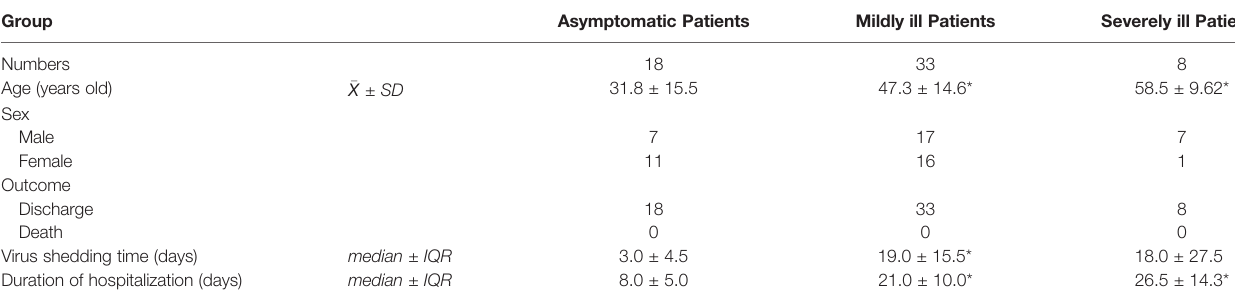
TABLE 1 | Patients involved in this